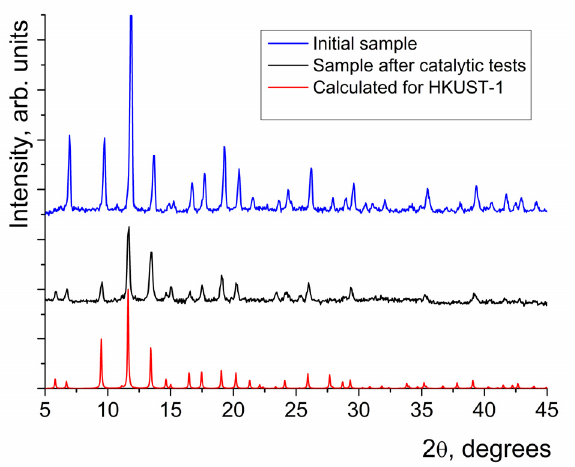
Figure 1. The experimental XRD patterns obtained for HKUST-1 after synthesis and after catalytic tests and a theoretically calculated one for HKUST-1.